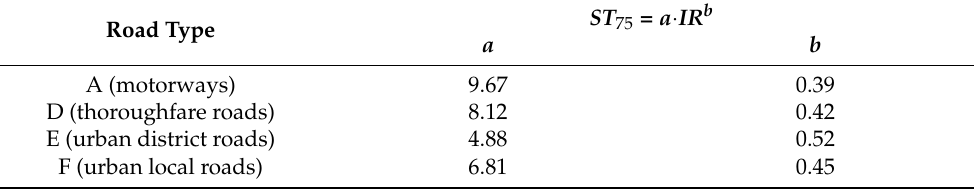
Figure 10. Regression of the median values of the hourly IR versus ST 75 values for each type of road. Table 7. Values obtained for the constants a and b in the regression Equation (5) between ST 75 and IR . Road